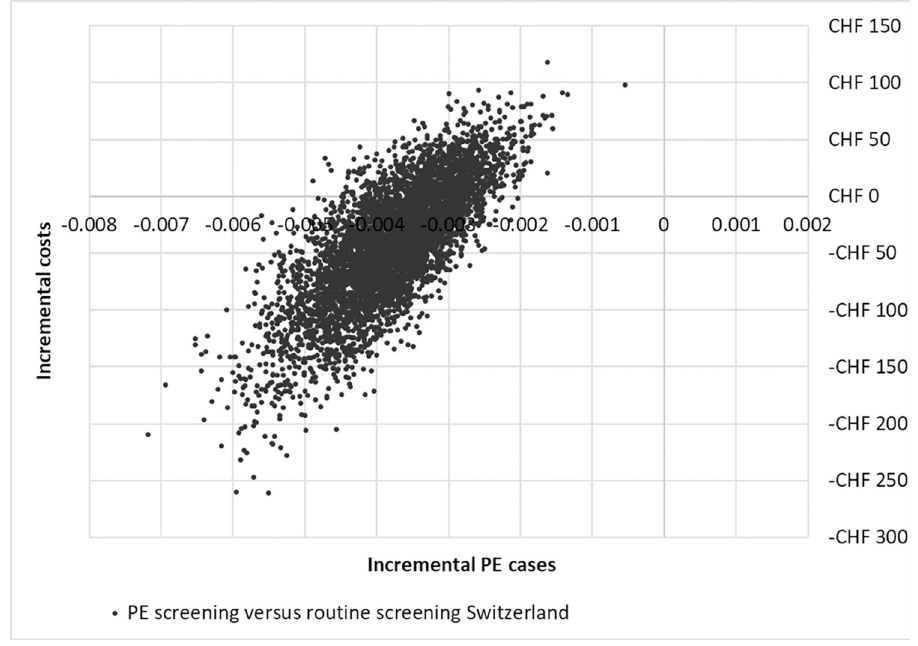
Fig 5. Cost-effectiveness plane